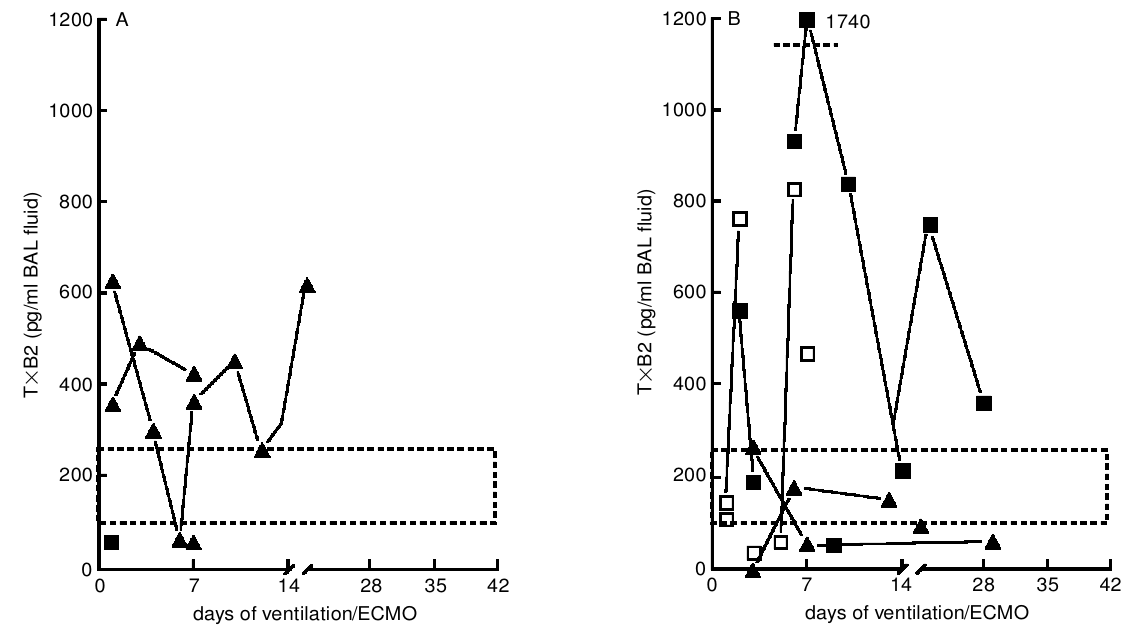
FIG. 2. The concentrations of TxB 2 in BAL ¯ uid of non-surviving CDH patients (A) and CDH survivors (B) are shown. Conventionally ventilated patients, j , u ; ECMO-treated patients, n , m . Closed symbols represent a poor clinical outcome: death (A) or O 2 -dependency at 28 days (B). Each measurement is indicated by an individual symbol, a line through the symbols indicates that more BAL procedures were performed on one patient. The box represents the interquartile range concentration of TxB 2 during the ® rst 2 days of ventilation in 10 control patients without